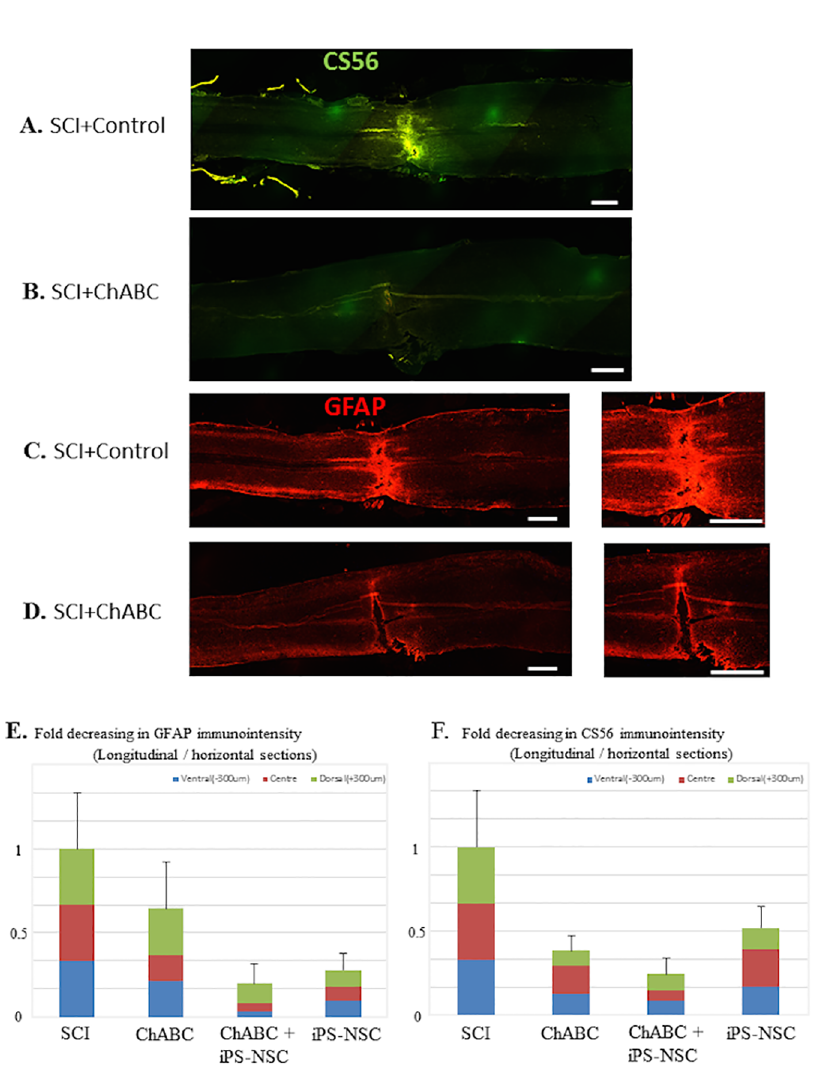
Fig 5. ChABCtreatmentreducescomponents of glial scarincluding astrocytesand chondroitin sulfate proteoglycans. Representative longitudinal andaxialsectionsimmunostainedfor CSPGs(CS56 + )